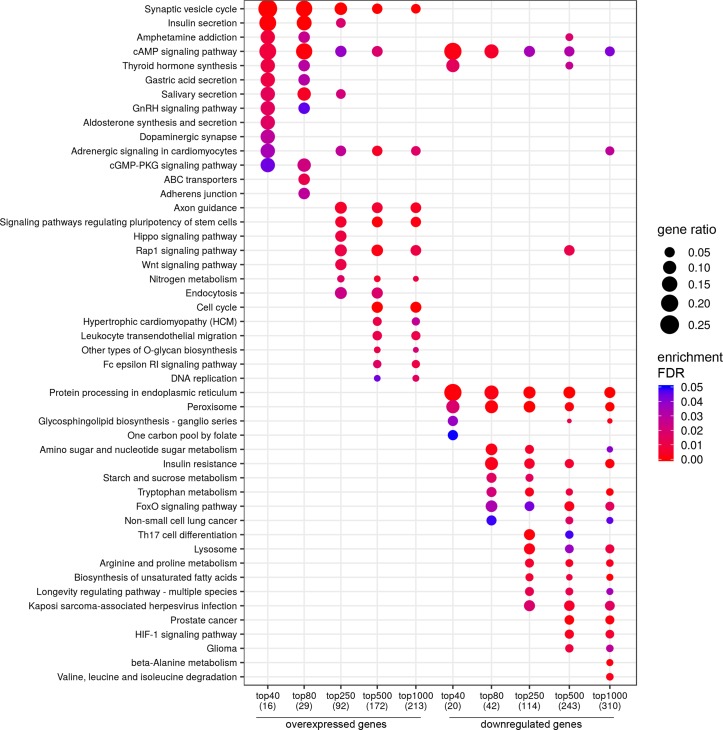
Dotplot showing the results of KEGG pathways enrichment analyses performed for top-40, 80, 250, 500, and 1,000 differentially expressed genes (either overexpressed or downregulated) between the groups of adverse and favorable prognosis (TCGA data). All the genes have passed the following thresholds: DESeq p-value < 0.01, Mann–Whitney p-value < 0.05, average expression-level fold change > 25%. Dot size indicates k/n ratio (“gene ratio”), where k is the number of genes participating in the current KEGG pathway (within top-40, top-80, or other top lists), and n is the number of genes (also within top-40, top-80, or other top lists) annotated as participants of any KEGG pathway (these numbers are provided in the brackets in the bottom of the figure). Dot color indicates the enrichment test FDR (Fisher’s exact test).